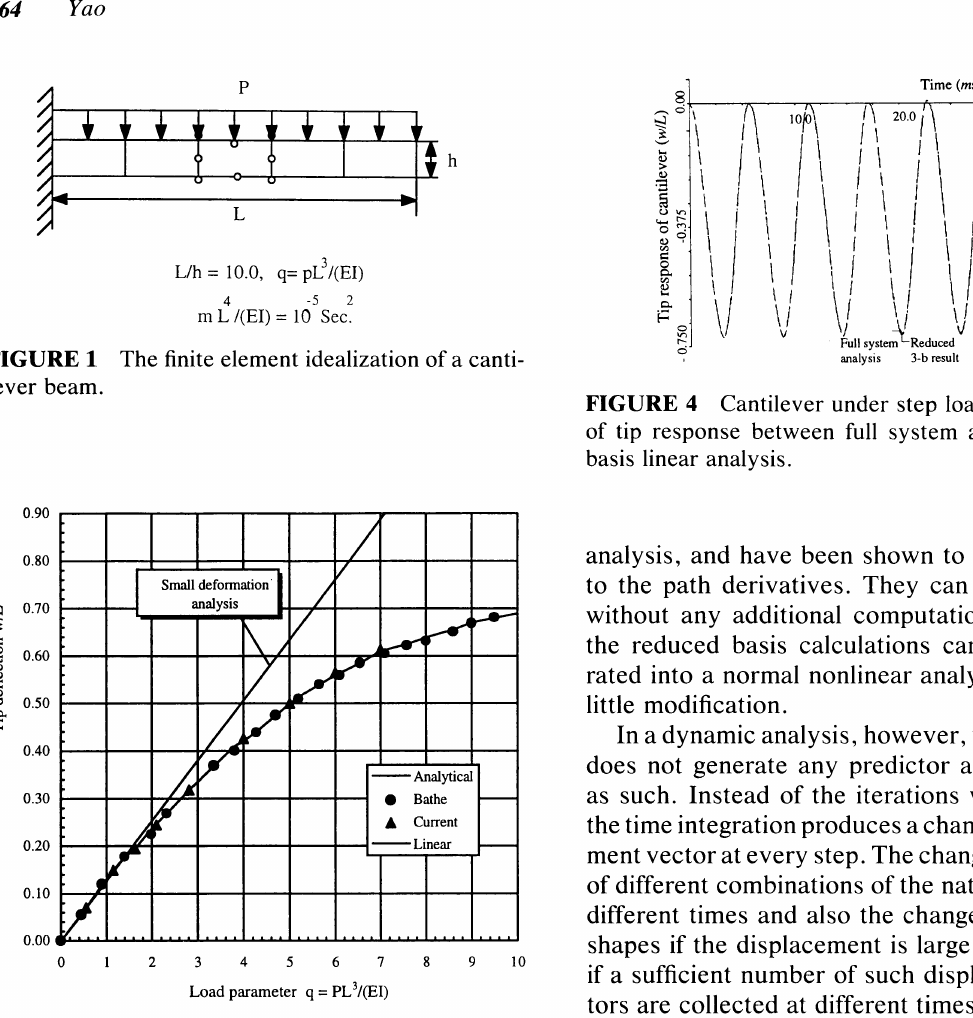
FIGURE 2 Comparison of nonlinear static analysis results of the cantilever.